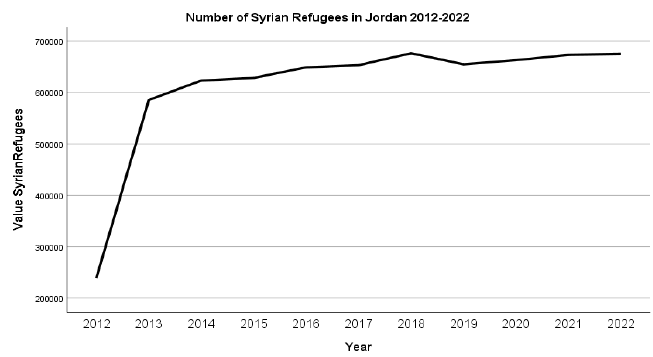
Figure 1: Number of Syrian refugees in Jordan (Source: Author‘s research 2022)